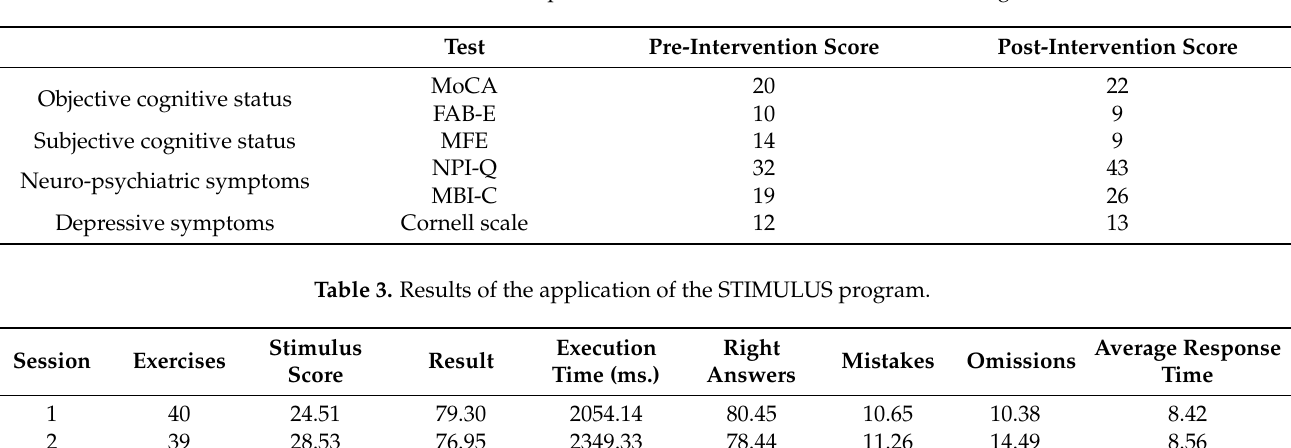
Table 2. Assessment of patient’s mental status before and after the cognitive intervention.